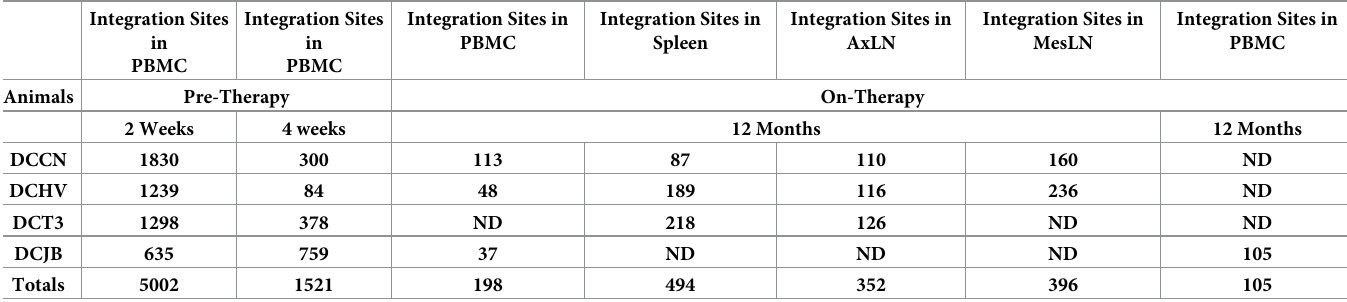
Table 7. Number of total � integration sites in samples from four macaques. Integration Sites in